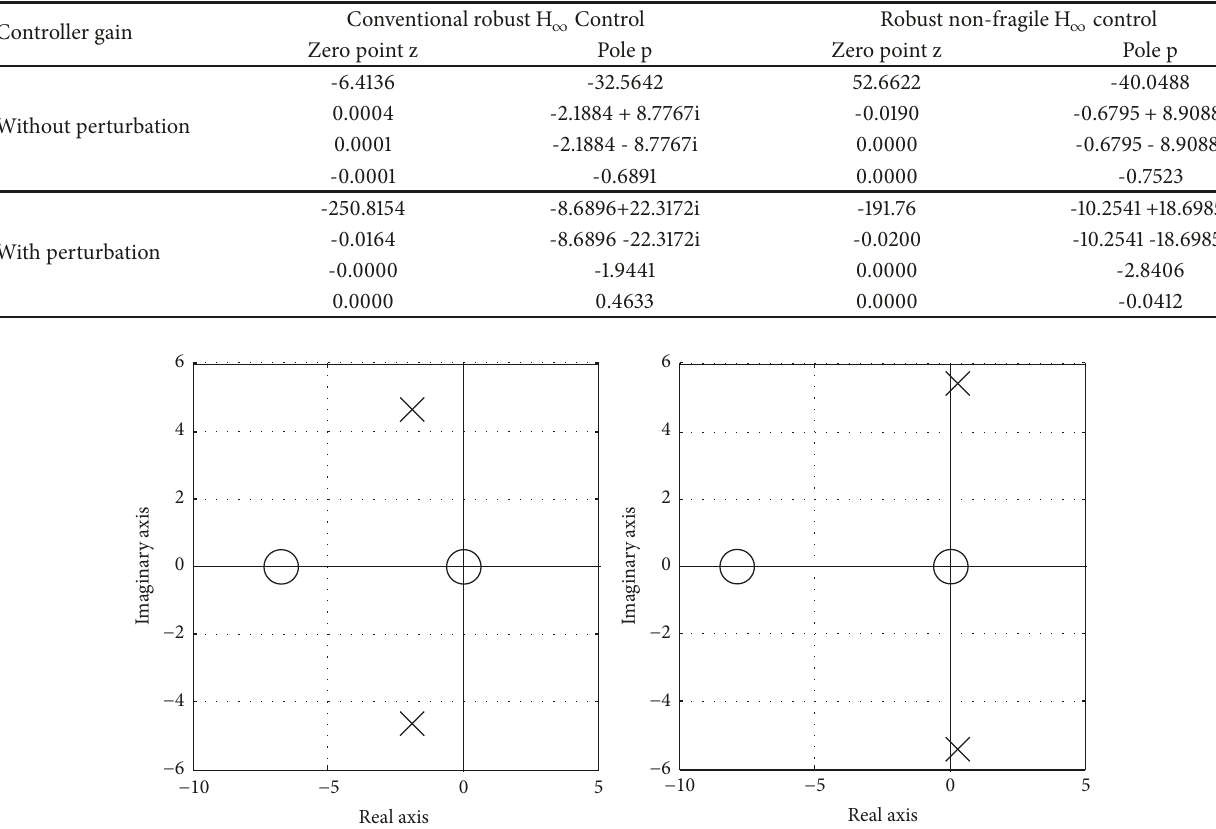
Table 6: Vehicle body vibration acceleration zero pole value.